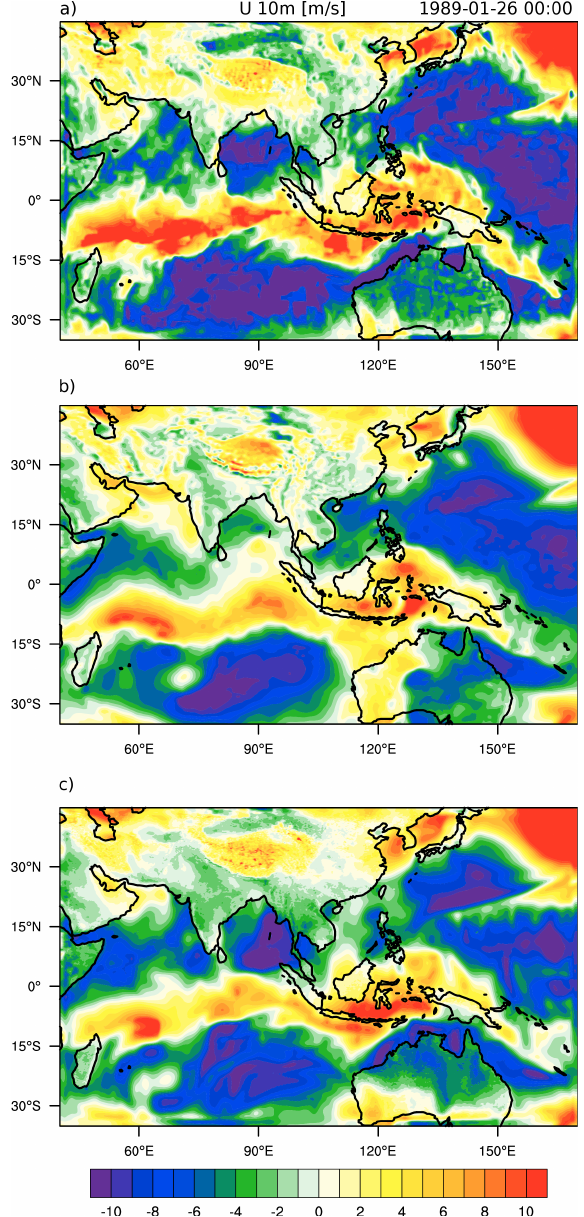
Fig. 1. (a) The 10m wind in ms − 1 as forecasted for five days from Fig. 1. (a) The 10 m wind in ms − 1 as forecasted for 5 days from 21 21 January 1989 by the terrain-following model LM; (b) as (a) , for January 1989 by the terrain-following model LM; (b) as (a) , for the the zero-day forecast from 26 January (“verification”); (c) as (a) , 0 day forecast from 26 January (“verification”); (c) as (a) , for the for the cut-cell model cut-cell model LMZ.